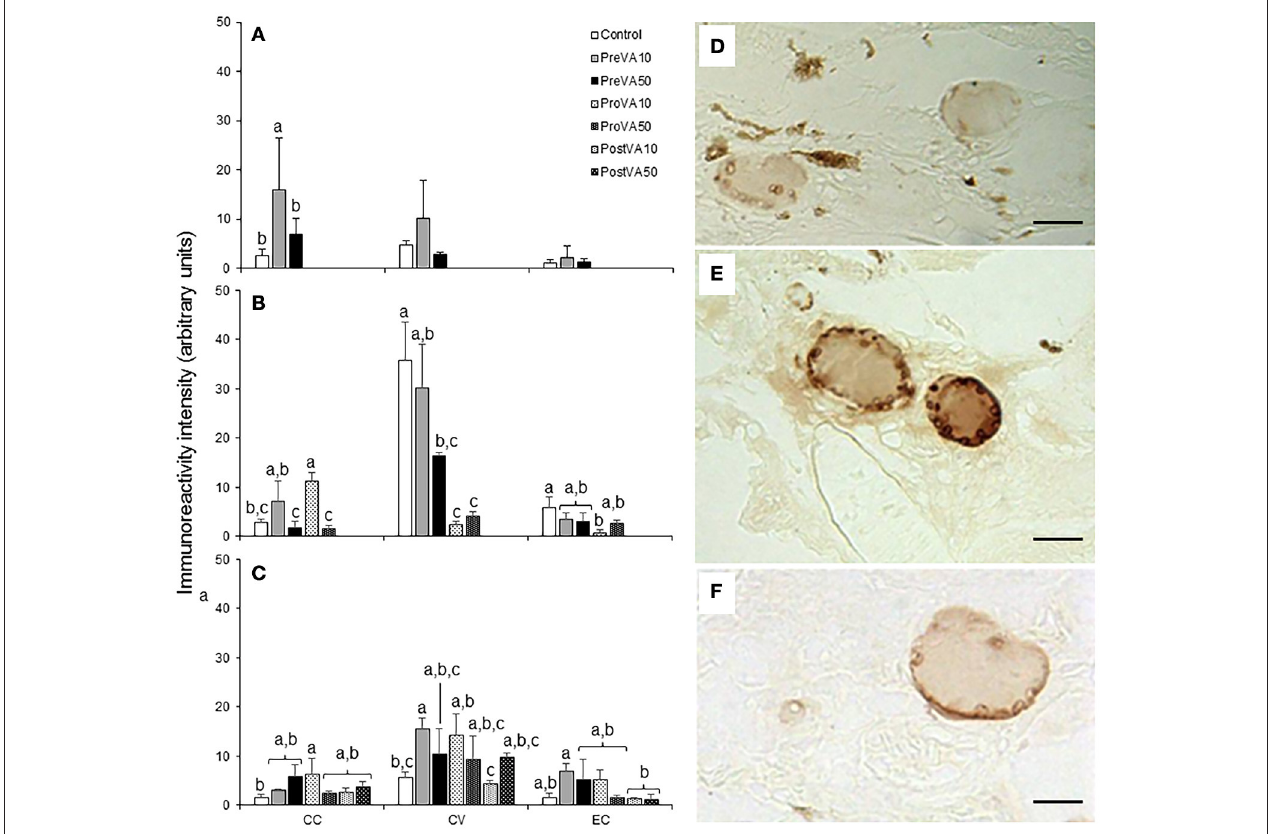
FIGURE 8 | Semi-quantitative assessment of triiodothyronine (T3) hormone (mean ± standard deviation) content by using immunohistochemical approaches in Senegalese sole fed with experimental diets. T3 content at 10 (A) , 21 (B) , and 55 (C) dph. A detailed view of the immunoreactive intensity in thyroid follicles in a Control (D) , PreVA10 (E) , and PreVA50 (F) larvae at 10 dph. CC , colloid content; CV , cortical vesicles content; EC , epithelial cells content. For a detailed description about the different experimental groups, please see the legend of Figure 1 . Different letters at the top of each bar denotes statistically significant differences among experimental groups (ANOVA, P < 0.05; N = 3). Scale bar = 200 µ